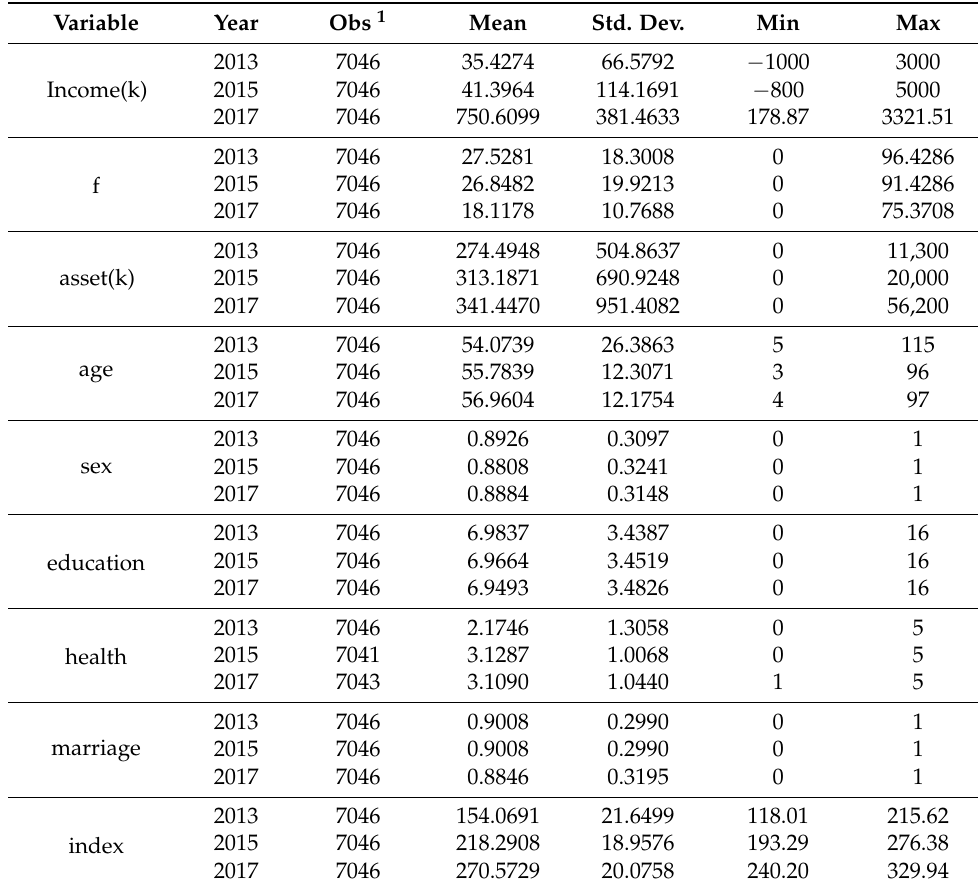
Table 3. Descriptive statistics.